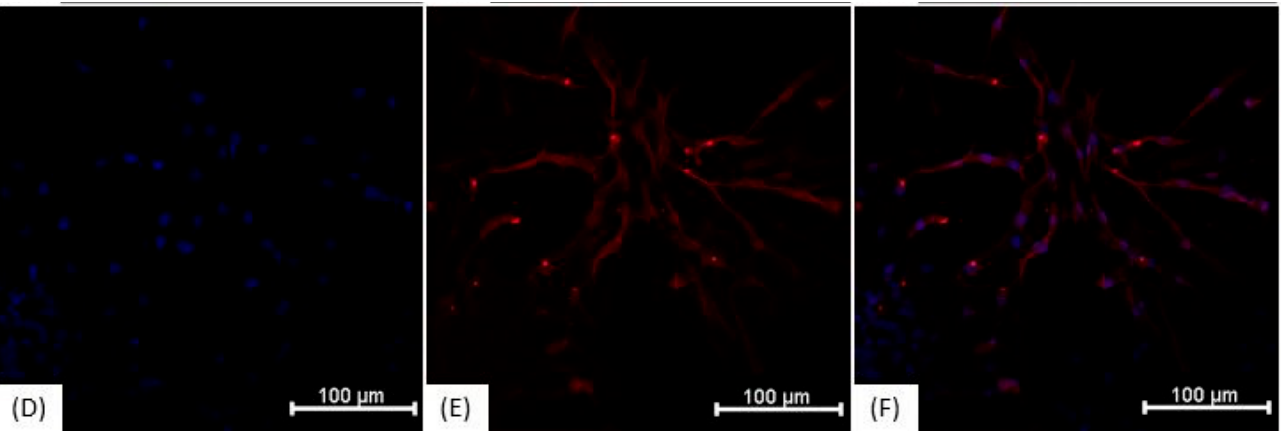
Figure 6. Immunocytochemistry of neurosphere-derived NPs cultivated on NFBX membrane and dissociated on polystyrene plates. ( A ) NPs cultured on NFBX membrane marking the nucleus with Hoechst (blue); ( B ) Anti-AMOT antibody with cytoplasmic labeling (FITC—green); ( C ) Overlapping images A and B; ( D ) Hoechst (blue) marking the nucleus of the cells; ( E ) Anti-YAP1 antibody with cytoplasmic labeling (Cy5—red); ( F ) Overlapping images D and E images. The images were taken with In Cell Analyzer 2000, GE (20×). Scale bars, 100 µm. NFBX, natural functional biopolymer matrix; NPs, neural precursors.